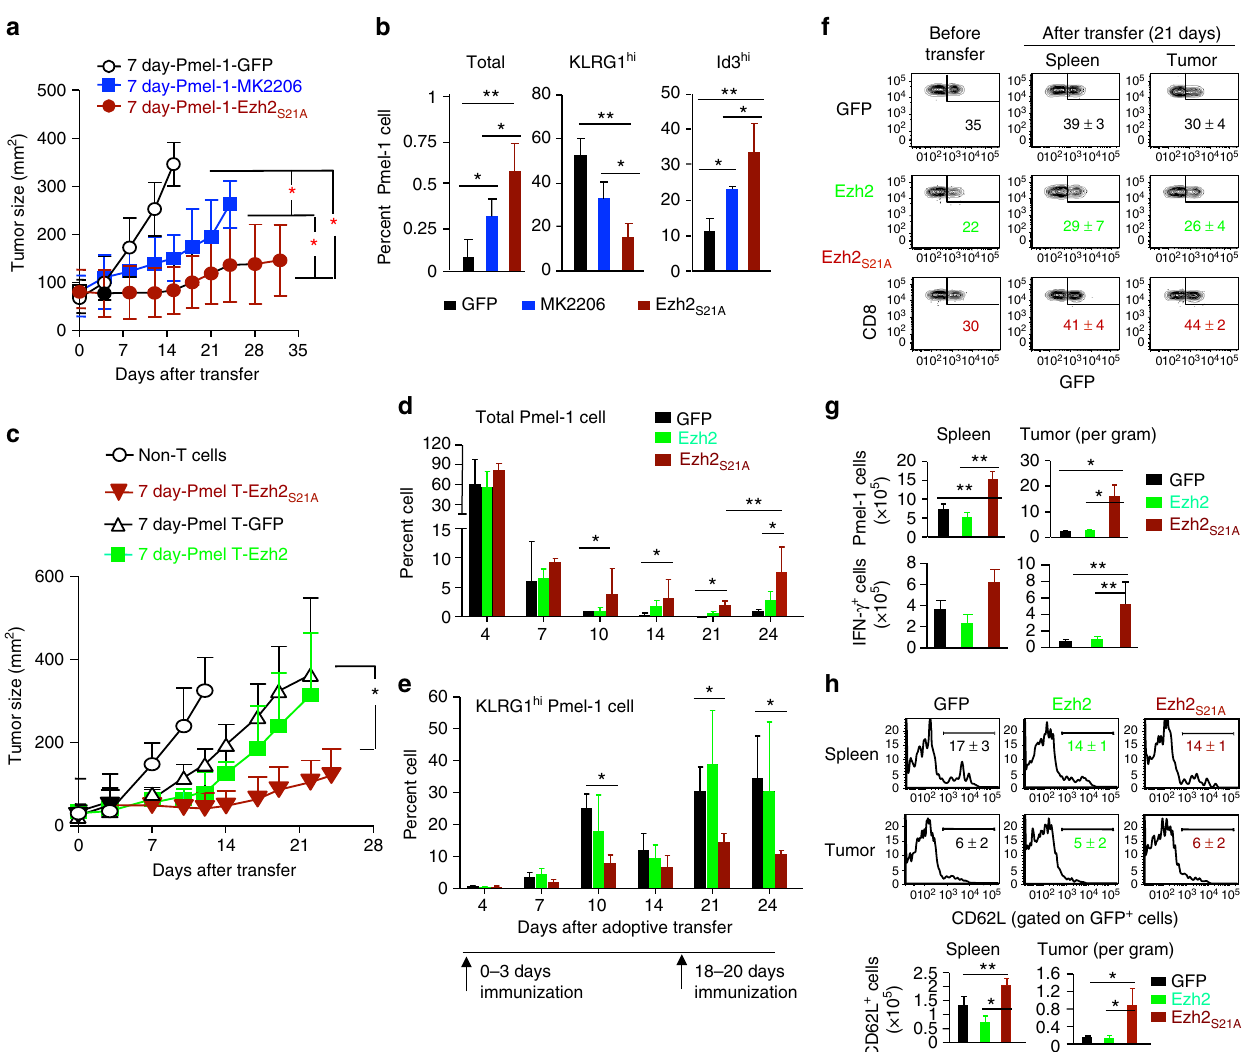
Fig. 7 Inhibiting Akt-mediated Ezh2 phosphorylation improves antitumor immunity. a , b Ex vivo-expanded 7 day-Pmel-1 cells (Thy1.1 + ), MK2206-treated 7 day-Pmel-1 cells (Thy1.1 + ), or 7 day-Pmel-1 cells infected with MigR1 retrovirus encoding Ezh2 S21A (Thy1.1 + , 5 × 10 5 T cells per mouse) were transferred